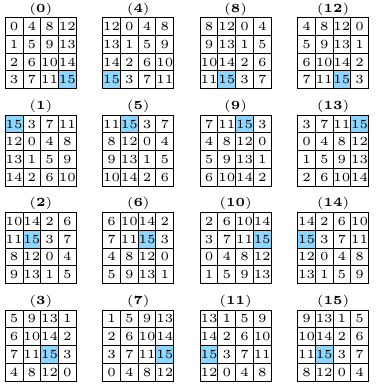
Figure 16: Permutations of numbers of solutions for each input byte, where the bold index in parentheses refers to the position of the δ -sets in the plaintext, i squares the index of the output (colliding) cell i ( i ) = (0 , 15), the best distinguisher for Small- AES . in , i out